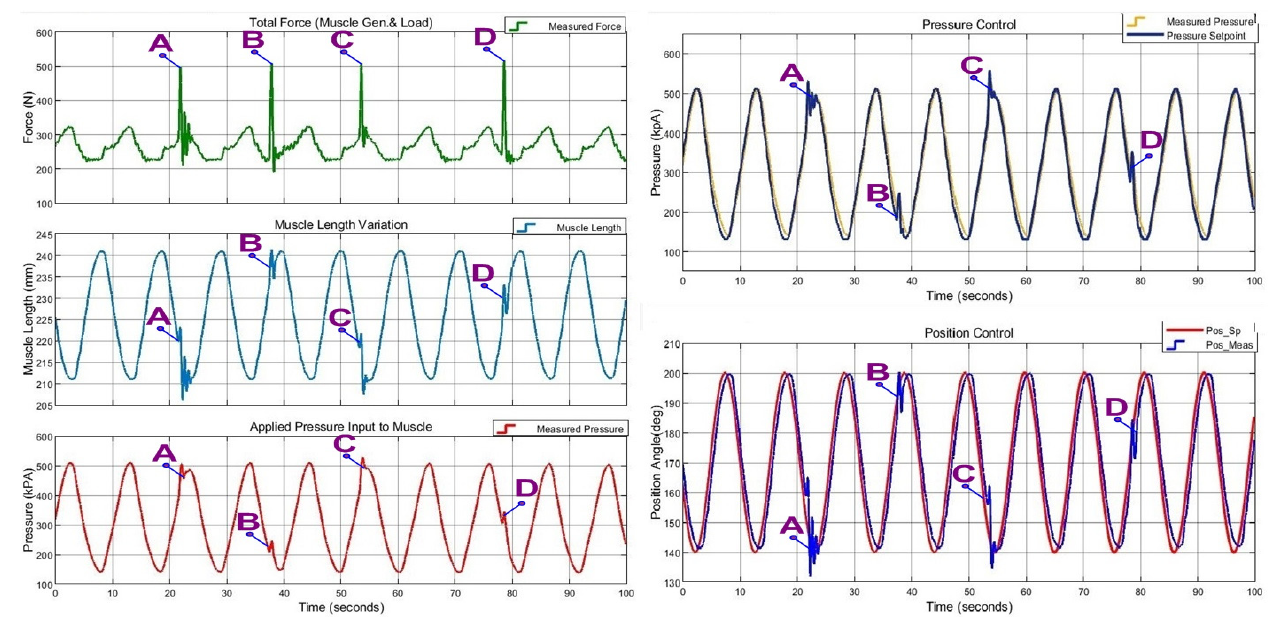
Figure 25. Impulsive force load application and overall system response at 0.1 Hz sinusoidal trajectory tracking operation. Table 7. Numerical values for critical points in Figure 25.